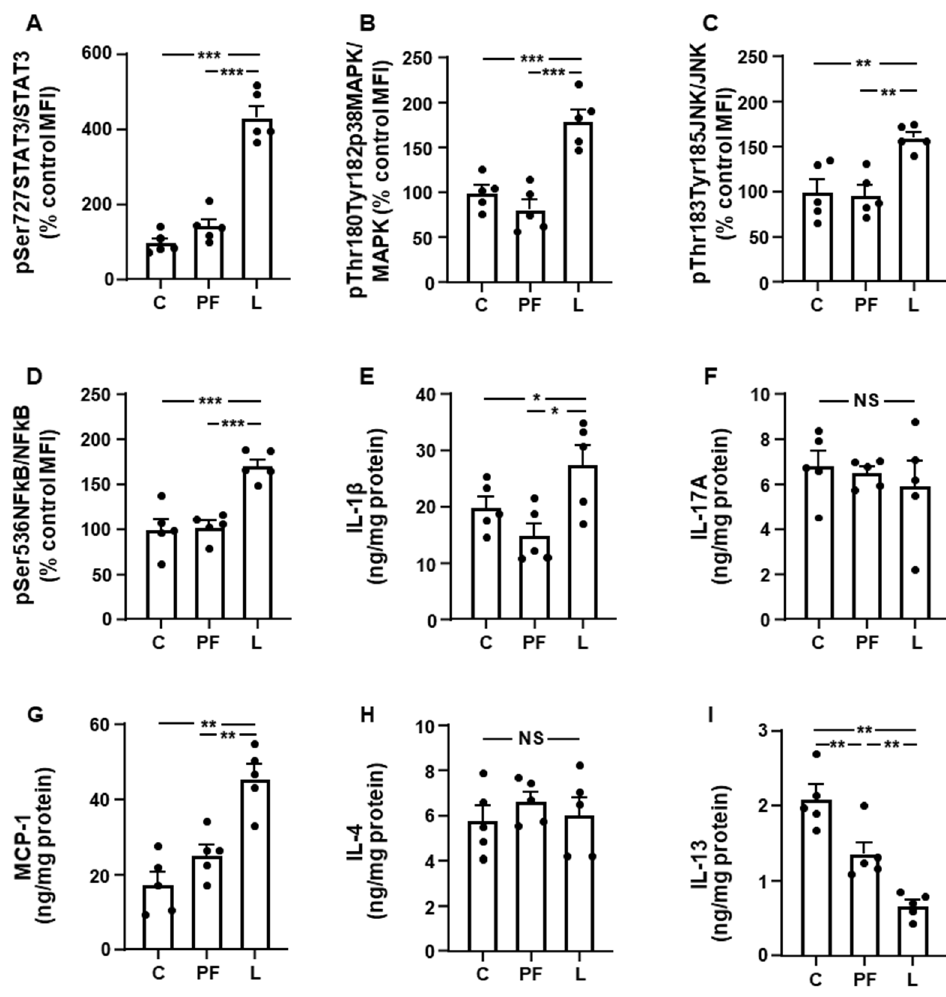
Figure 1. Effect of chronic central leptin infusion on inflammatory markers in inguinal fat. Relative protein levels of ( A ) signal transducer and activator of transcription 3 (STAT3) phosphorylated (p) at Ser727 (pSer727STAT3), ( B ) phosphorylated p38 mitogen-activated protein kinase (p38MAPK) at Thr180 and Tyr182 (pThr180Tyr182p38MAPK), ( C ) c-Jun N-terminal kinase (JNK) phosphorylated at Thr183 and Tyr185 (pThr183Tyr185JNK), and ( D ) nuclear factor kappa B (NFkB) phosphorylated at Ser536 (pSer536NFkB), and ( E ) interleukin (IL)1 β , ( F ) IL-17A, ( G ) monocyte chemoattractant protein-1 (MCP-1), ( H ) IL-4 and ( I ) IL-13 content in the inguinal fat of control rats ( C ), pair-fed rats (PF) and rats receiving a chronic intracerebroventricular leptin infusion (L). Data are presented as means ± SEM. MFI, median fluorescence intensity; NS, non-significant. * p < 0.05, ** p < 0.01, *** p < 0.001.